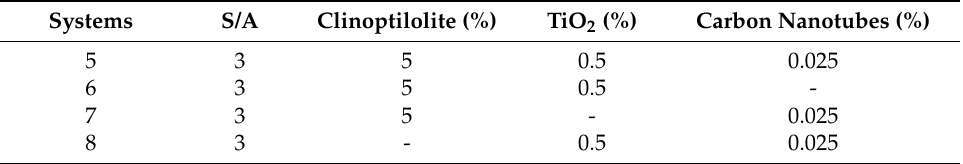
Table 5. Composition of mixed systems with multiple